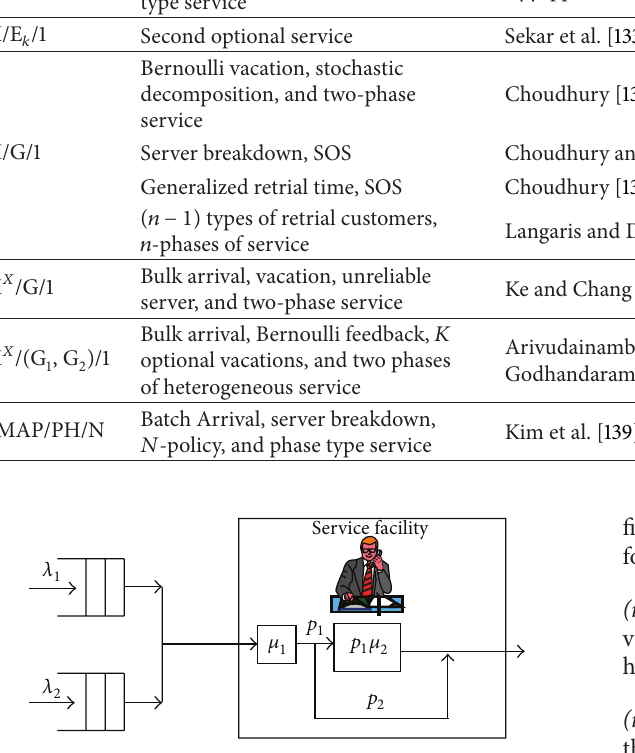
Figure 4: Priority queueing